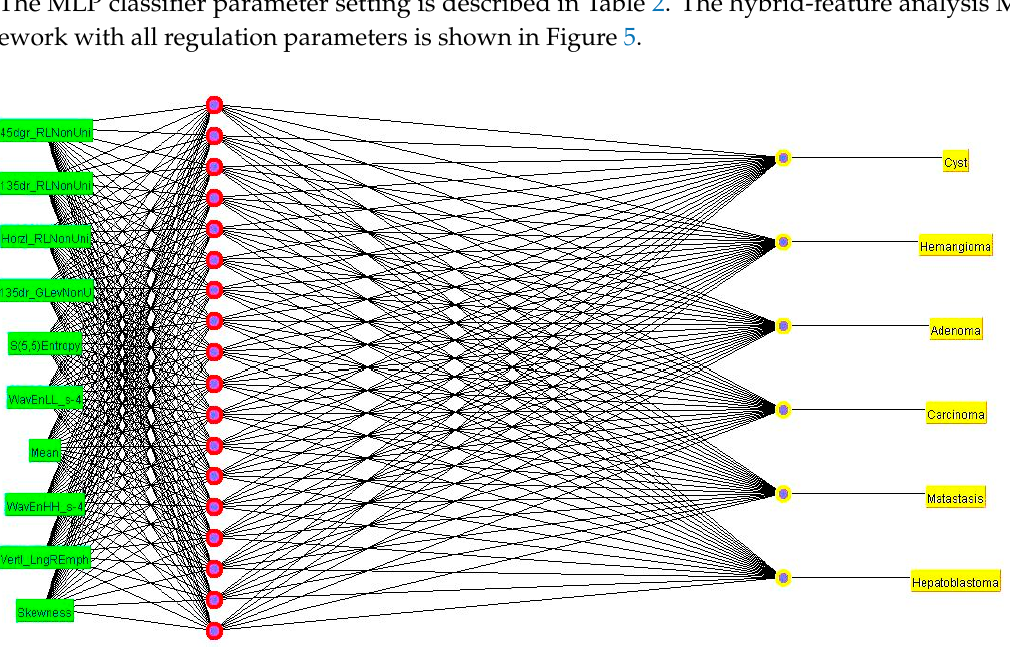
Table 2. Implemented multilayer perceptron (MLP) classifier constraints values.